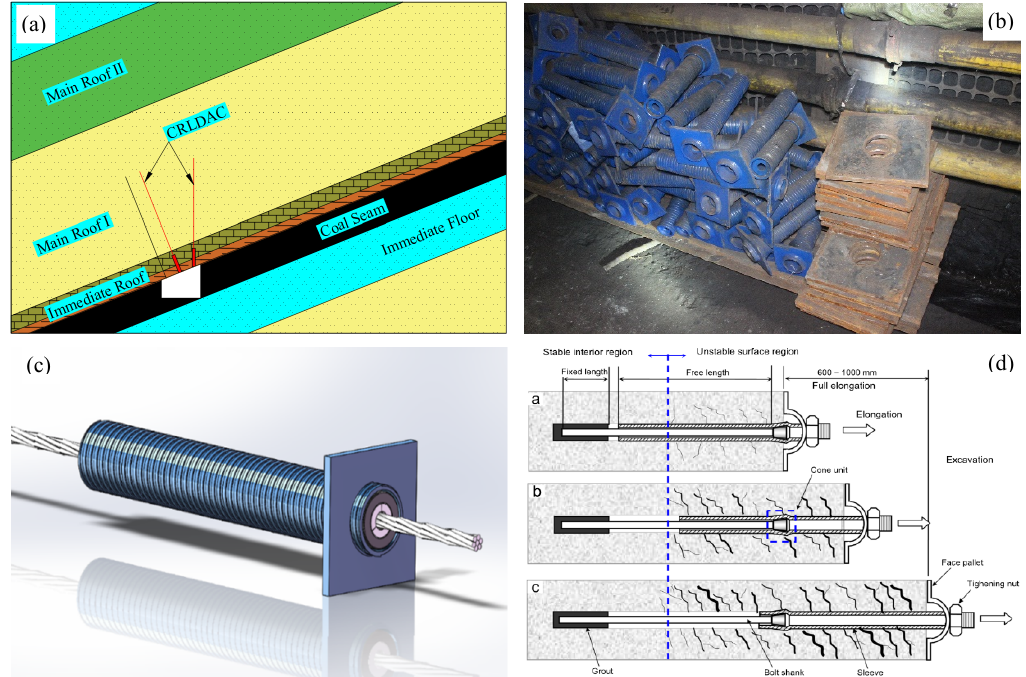
Figure 2. Constant resistance large deformation anchor cable (CRLDAC) device and principles: ( a ) technology of CRLDAC; ( b ) constant resistance device and tray; ( c ) assembly of CRLDAC; ( d ) deformation principle of